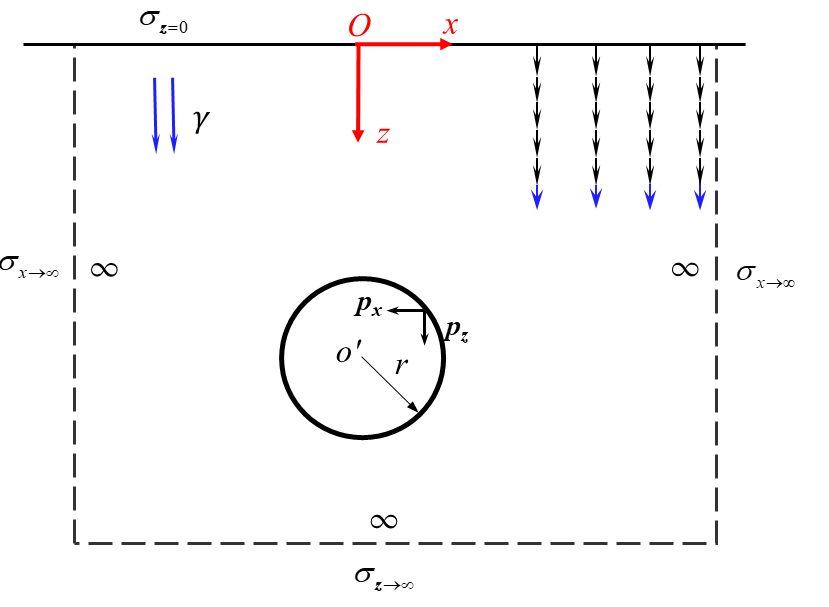
Figure 3. General boundary conditions of mechanical model.